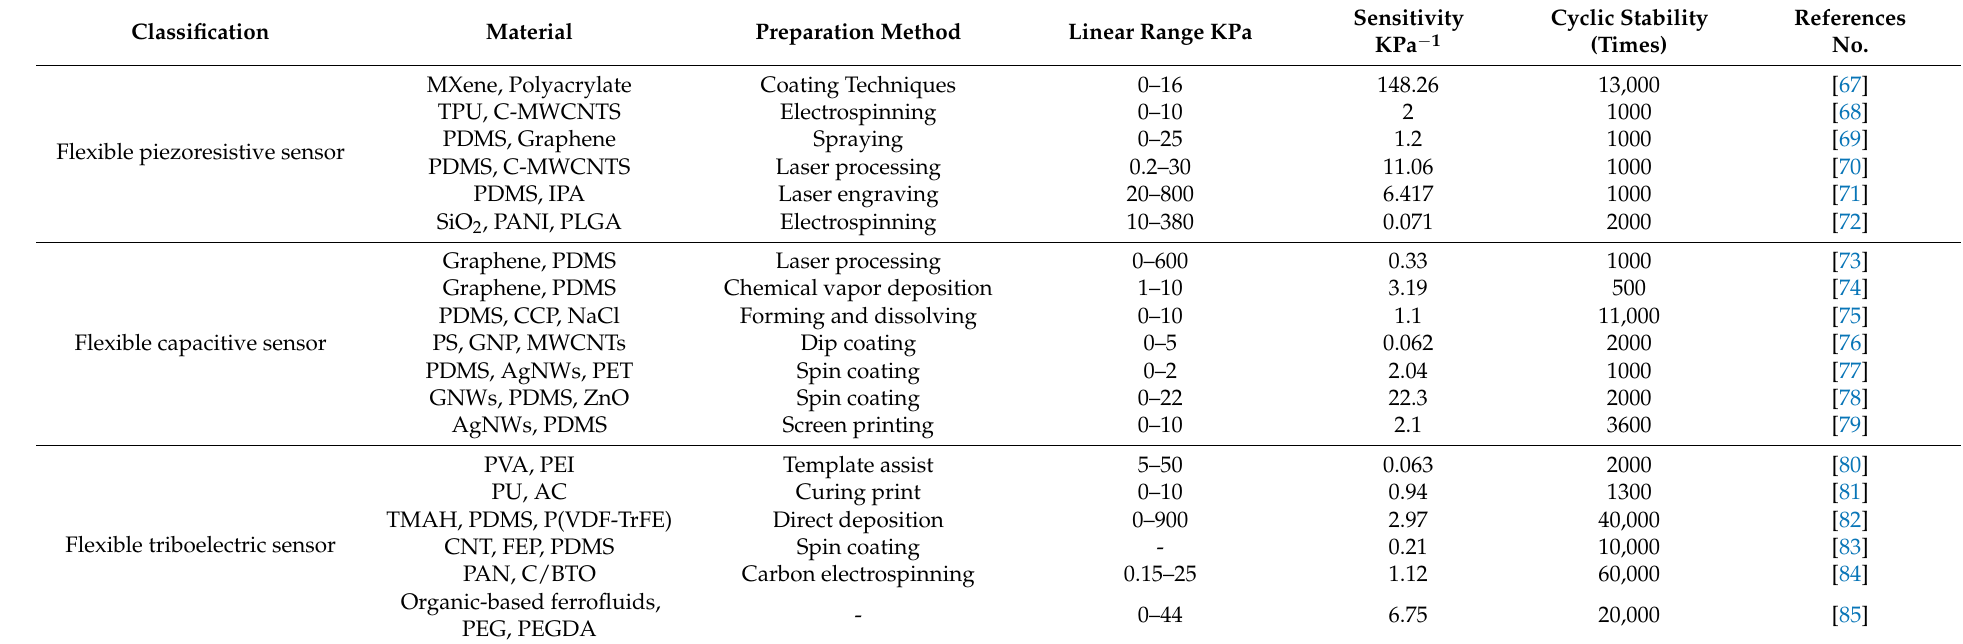
Table 1. Comparative study of flexible sensors with different sensing